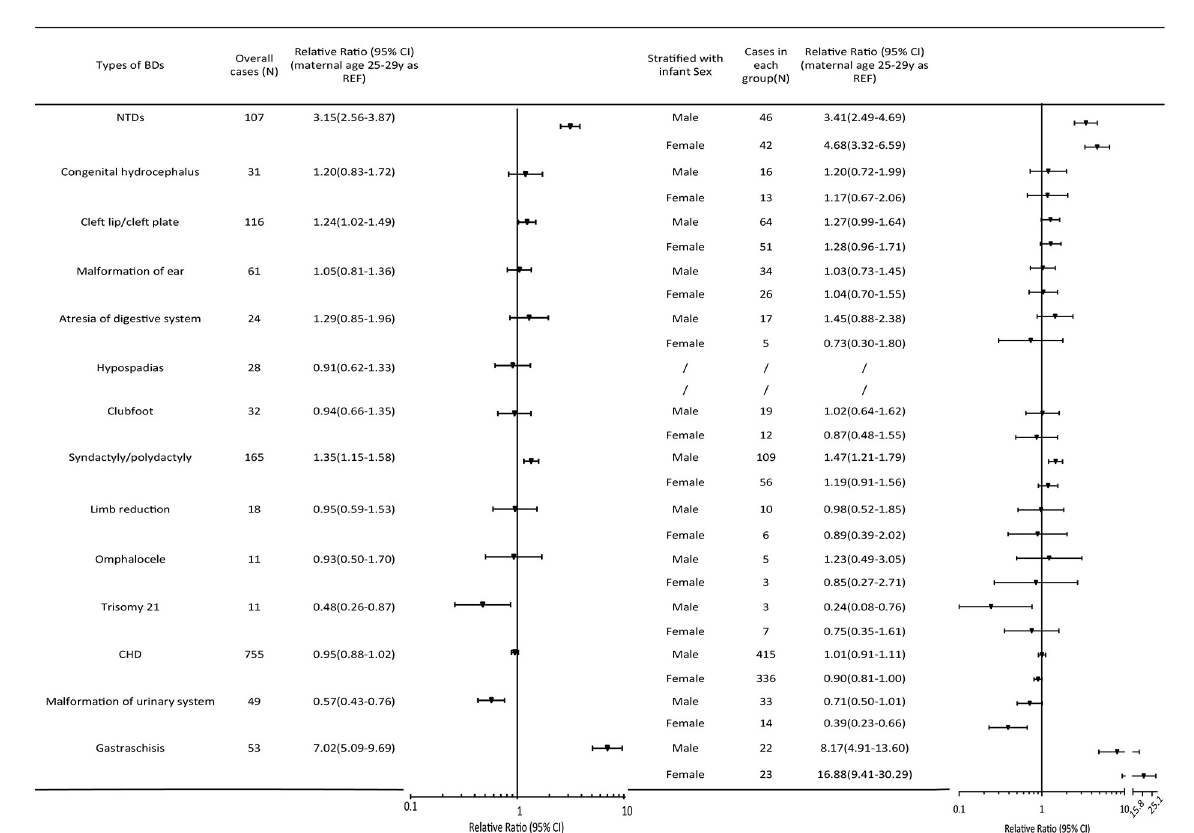
FIGURE2 Relative ratios (95%CI) of BD subtypes in the maternal age group < 20 years relative to the 25–29-year-old group. The pooled relative ratio and infant sex-specific relative ratio are expressed in comparison to those of infants born to mothers aged 25–29 years. Cleft lip/palate comprises cleft lip, cleft palate, and cleft lip with cleft palate. NTDs include spina bifida, anencephaly, and encephalocele. Atresia of the digestive system includes atresia of the rectum, anus, and esophagus. Diaphragmatic hernia, exstrophy of the urinary bladder, and other chromosomal abnormalities (except trisomy 21) were not presented in the Figure because of the low prevalence. CHD, congenital heart defect; CI, confidence interval; NTD, neural tube